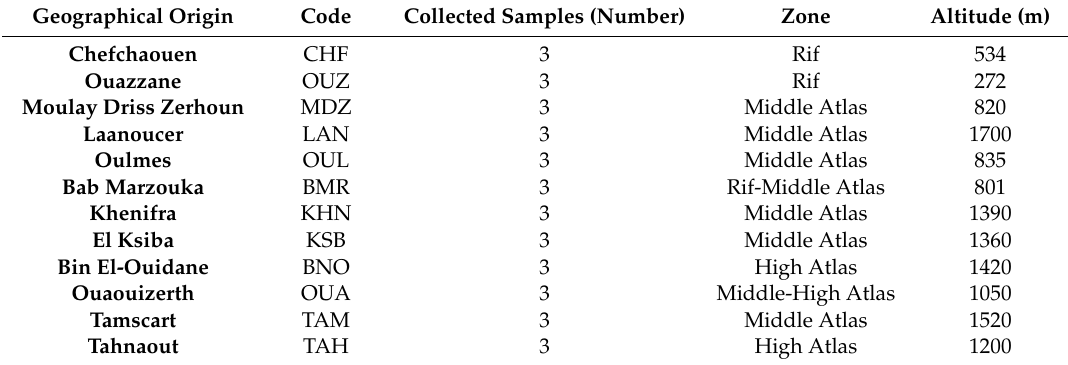
Table 1. Origins geographic of the di ff erent samples